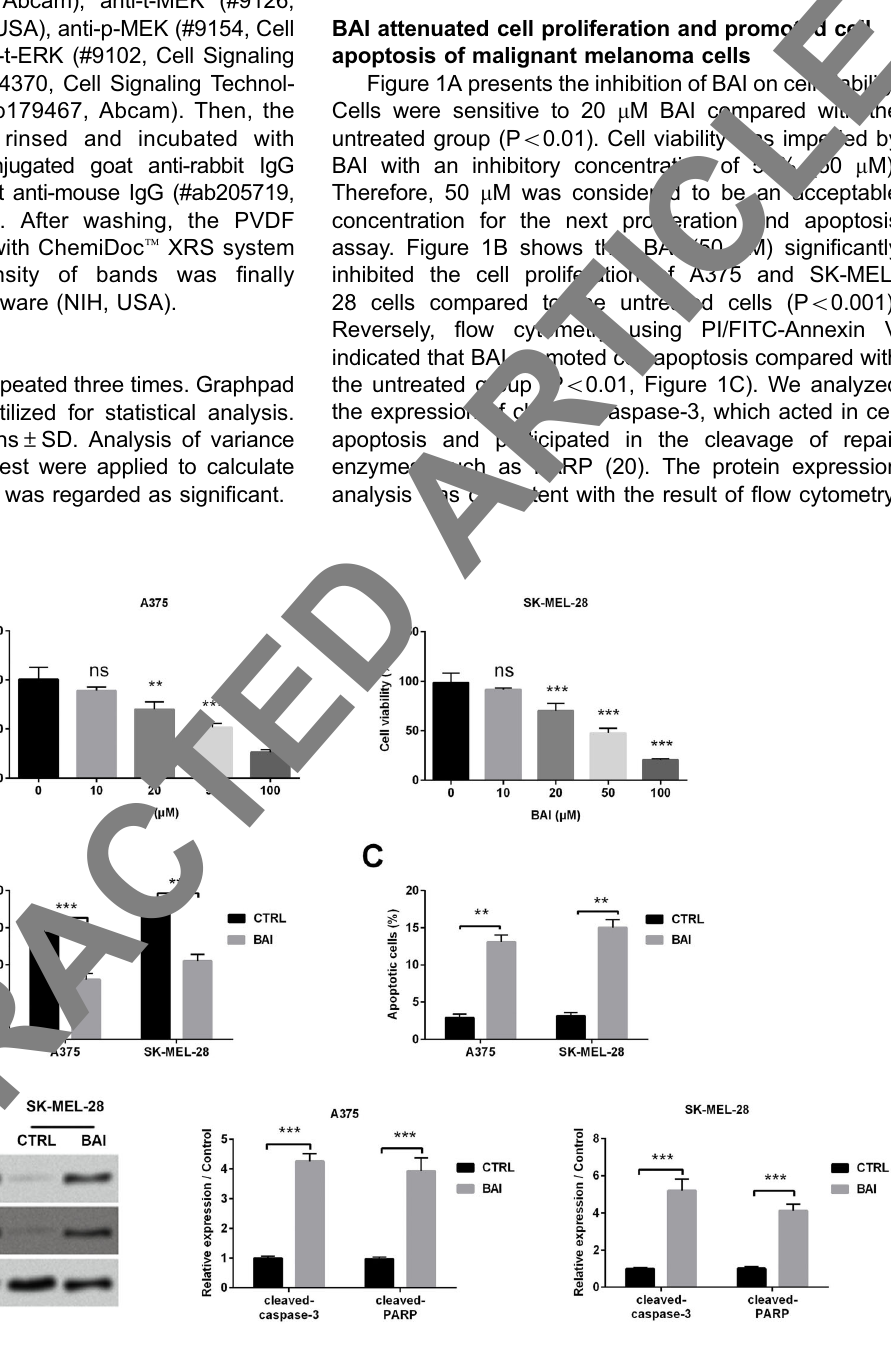
Figure 1. Baicalein (BAI) attenuated cell proliferation and strengthened cell apoptotic capacity of malignant melanoma cells. A , Cell viability of A375 and SK-MEL-28 cells followed by 24-h treatment with BAI (0, 10, 20, 50, and 100 m M) was assessed by CCK-8. B , Cell proliferation of melanoma cells was examined by bromodeoxyuridine (BrdU) assay. C , Flow cytometry was utilized to assess the apoptotic rate of melanoma cells. D , Expression of cleaved-caspase-3 and cleaved-PARP was tested by western blot assay. The relative expression of protein was normalized by b -actin. Data are reported as mean ± SD. **P o 0.01, ***P o 0.001 (ANOVA). ns: not signi fi cant; CTRL: